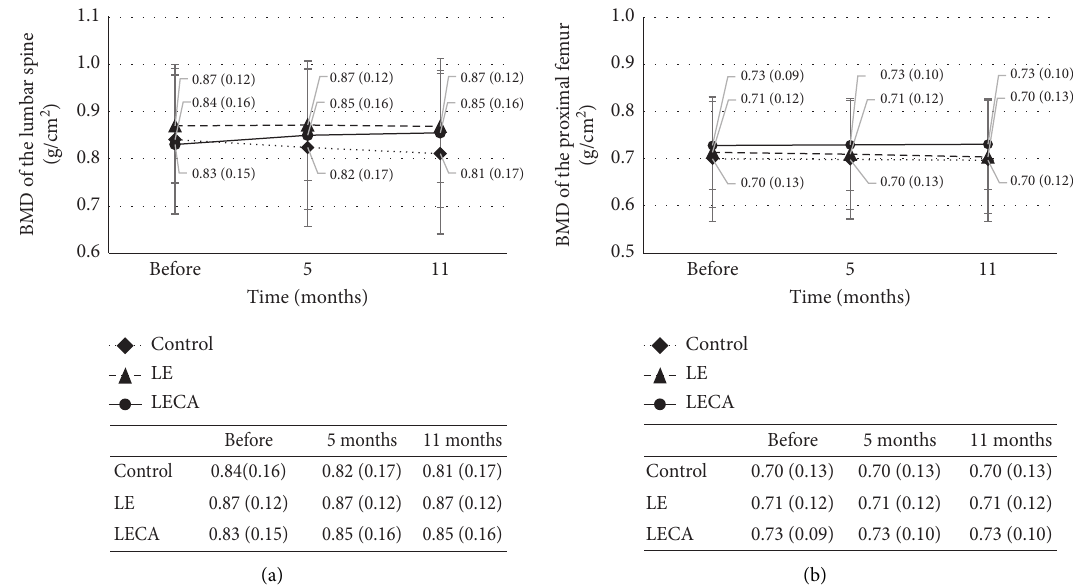
Figure 2: Relationship between ingested product and BMD 1 . (a) BMD of lumbar spine. (b) BMD of proximal femur. Values are shown as the mean (SD) with error bars. Dotted line is the control group, dashed line is the LE group, and solid line is the LECA group. Two-way factorial analysis of variance was performed with type of ingested product and intervention period as factors. p values are shown for ingested product (drink), intervention period (time), and interaction. (a) Drink: p � 0.666; time: p � 0.956; interaction: p < 0.001. (b) Drink: p � 0.771; time: p � 0.413; interaction: p < 0.0011. BMD: bone mineral density. SD: standard deviation. The LE group received a nonsupplemented lemon beverage containing citric acid. The LECA group received a lemon beverage containing citric acid supplemented with